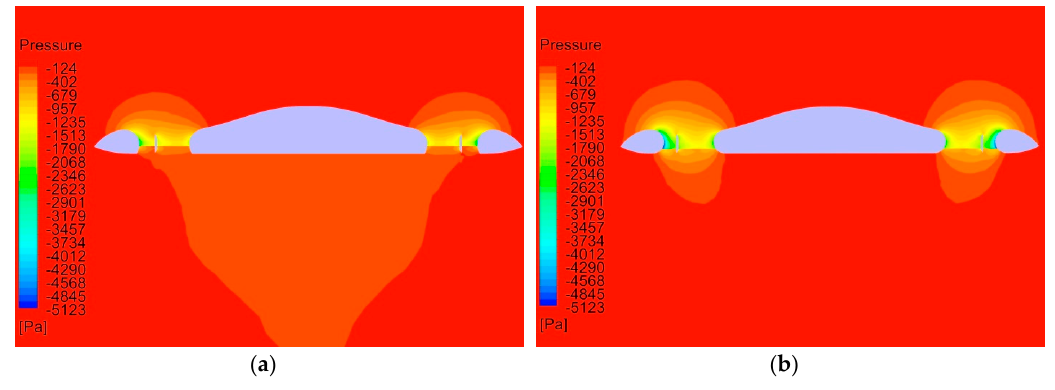
Figure 6. Static pressure contour in the central plane of aircraft. ( a ) Original fan configuration; ( b ) New fan configuration.